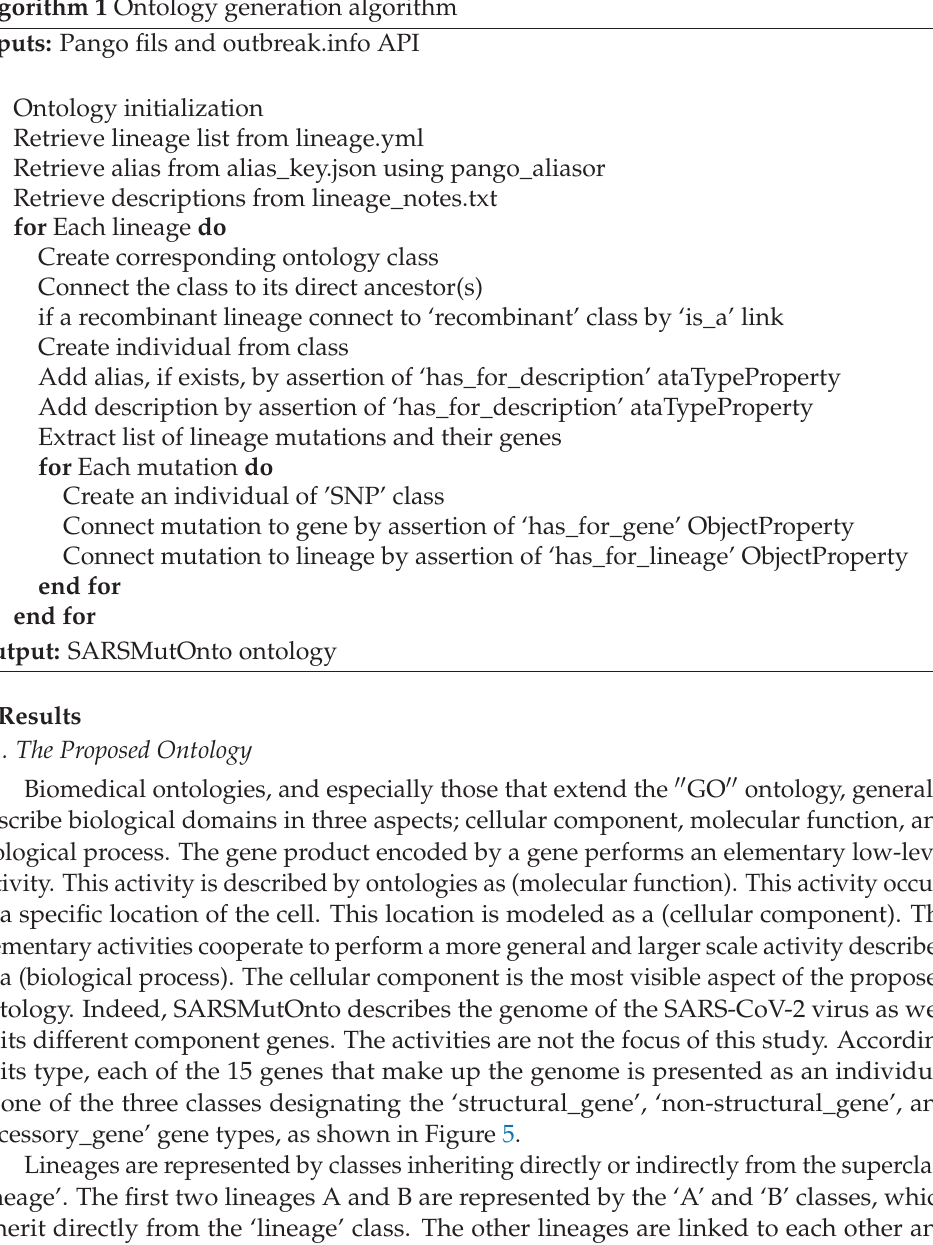
Algorithm 1 Ontology generation